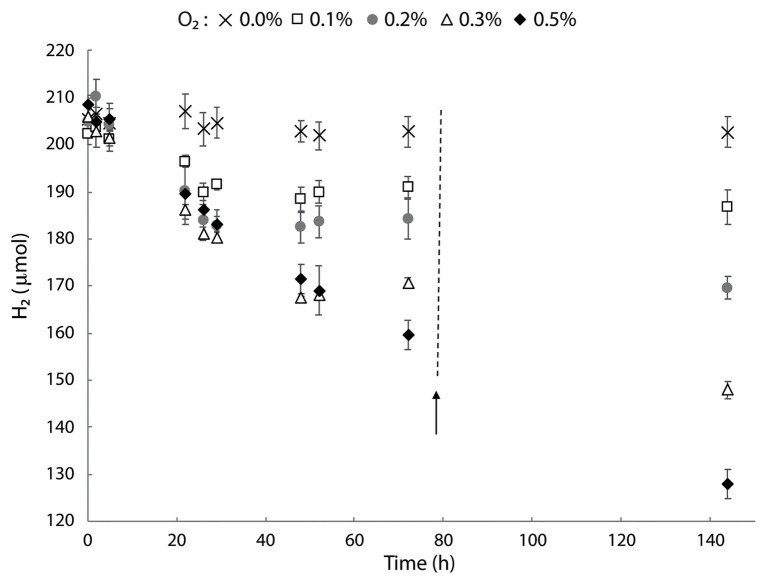
Hydrogen consumption in M. thermophilum AP8 with different O2 concentrations. Bottles were incubated with 0–0.5% O2 and the activity followed for 144 h. The black arrow indicates the addition of O2 to the initial concentration. Error bars represent the standard deviation over the average from three biological replicates.